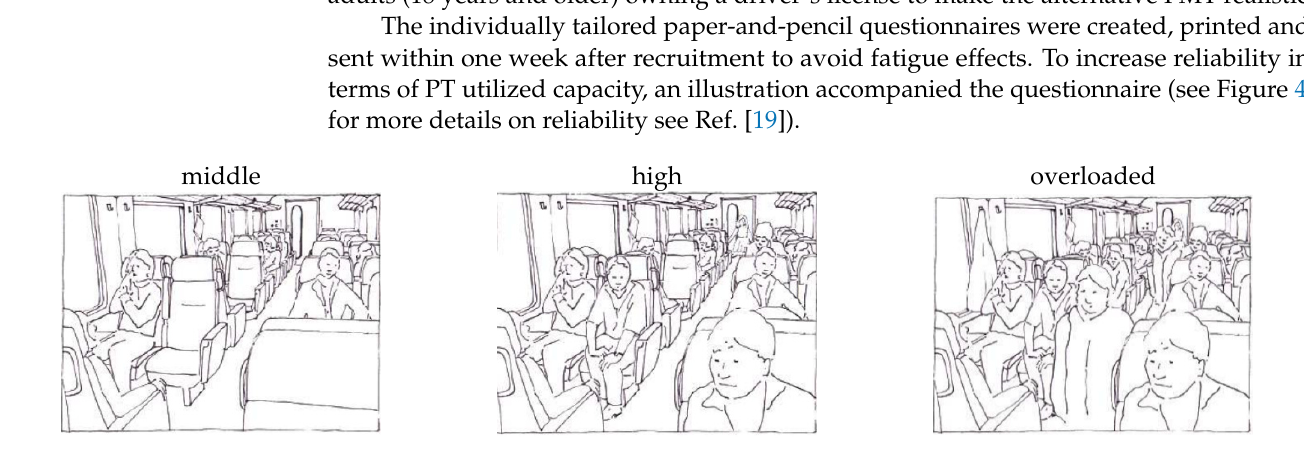
Figure 4. Illustration of capacity utilization (illustrations taken from Weis et al. [19]). Both the survey protocol and instrument followed the suggestions by Dillmann [39].